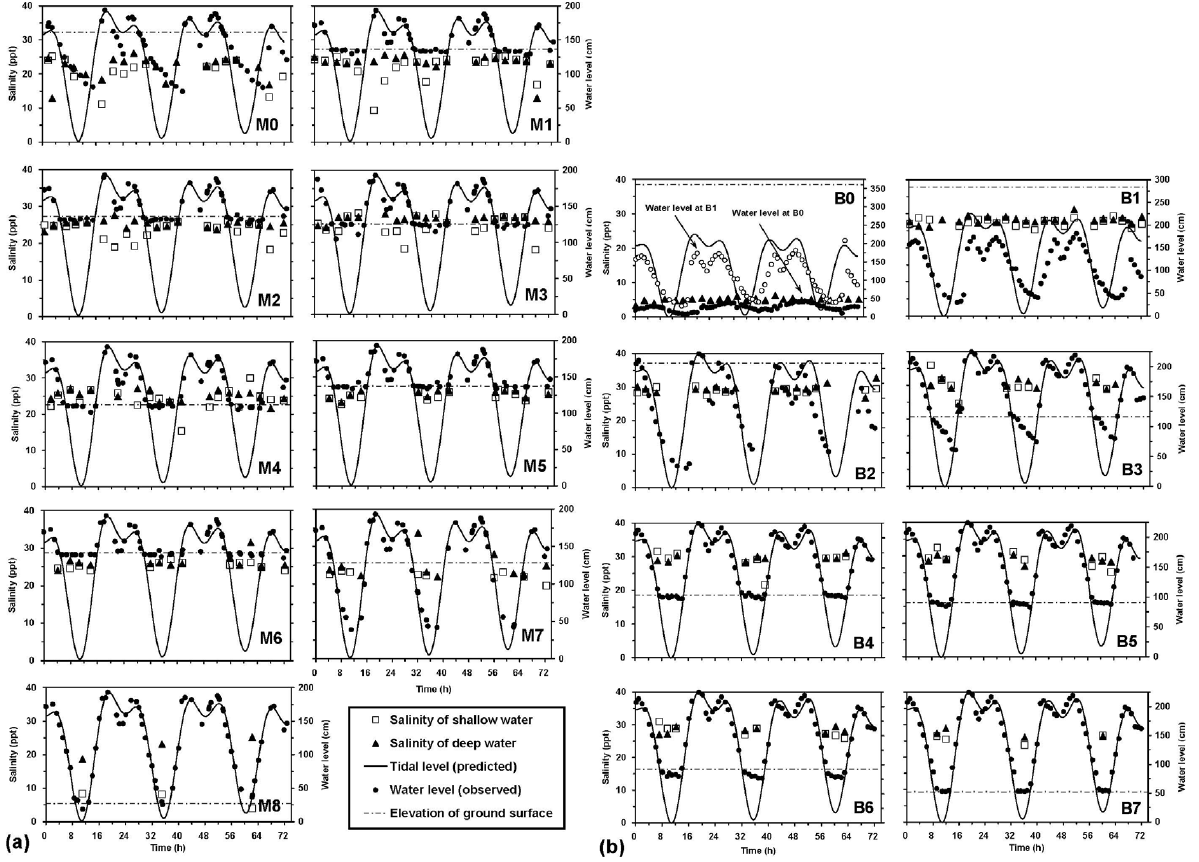
Fig. 4. Observed salinity (ppt) of groundwater and water level in monitoring wells along (a) mangrove transect M-M 0 and (b) bald beach transect B-B 0 . The initial time of zero hour corresponds to 25 December 2007, 08:00LT. The square symbols are the salinity of the ground- water at shallow location in the well, and the black triangle symbols are the salinity of the groundwater at deep location in the well. The shallow and deep locations for each well were indicated in Fig. 2 and given in Tables 1 and 2. The filled circles are observed water level. The ground surface elevation (thin dash-dot line) at each well and the tidal level (thick line) are also shown. For convenience of comparison, observed water table at B1 was also shown in empty circles in the panel for B0.